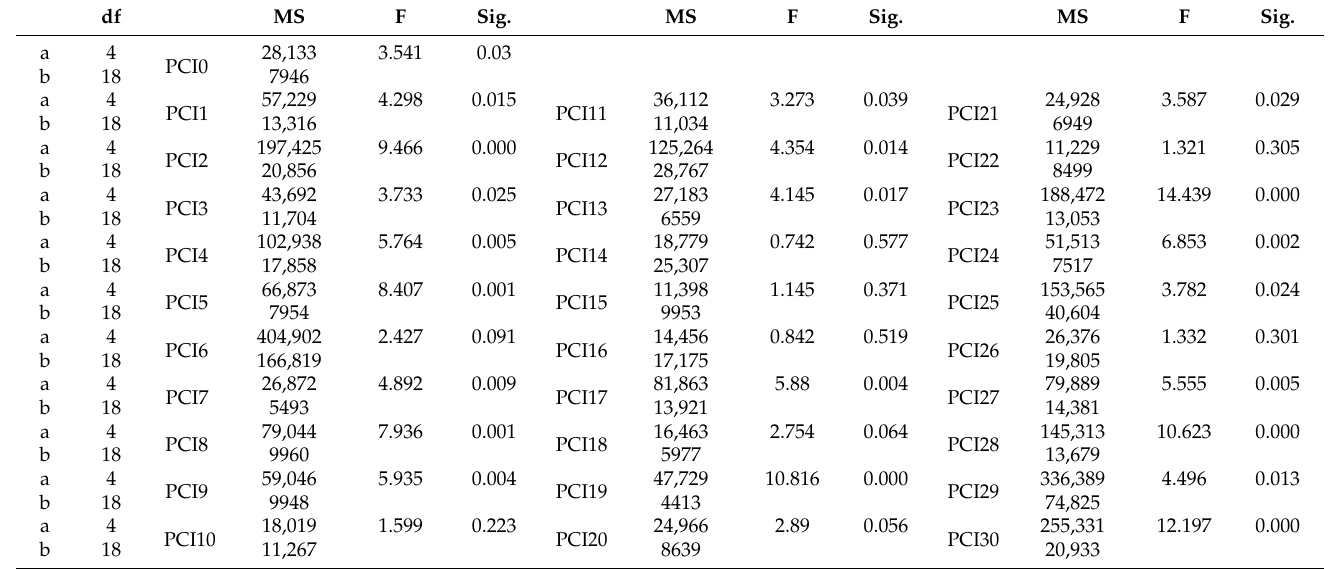
a = between groups; b = within groups. Note: MS = mean square.